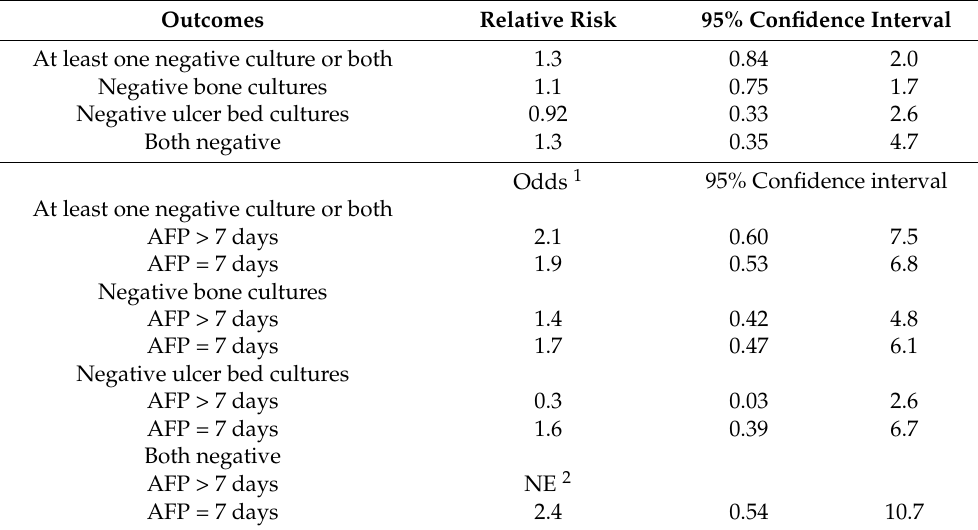
Table 3. Relative risks and odds for negative cultures in people with prior antibiotic